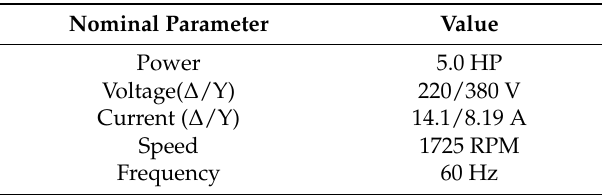
Table 2. Motor Parameters.